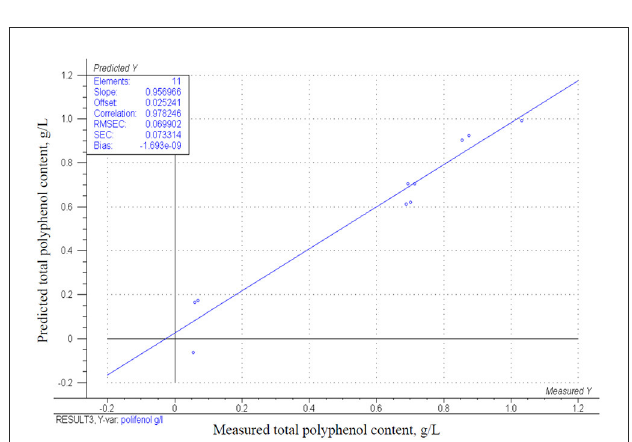
FIGURE9 Correlation of the obtained model and the measured results for the change in total polyphenol content